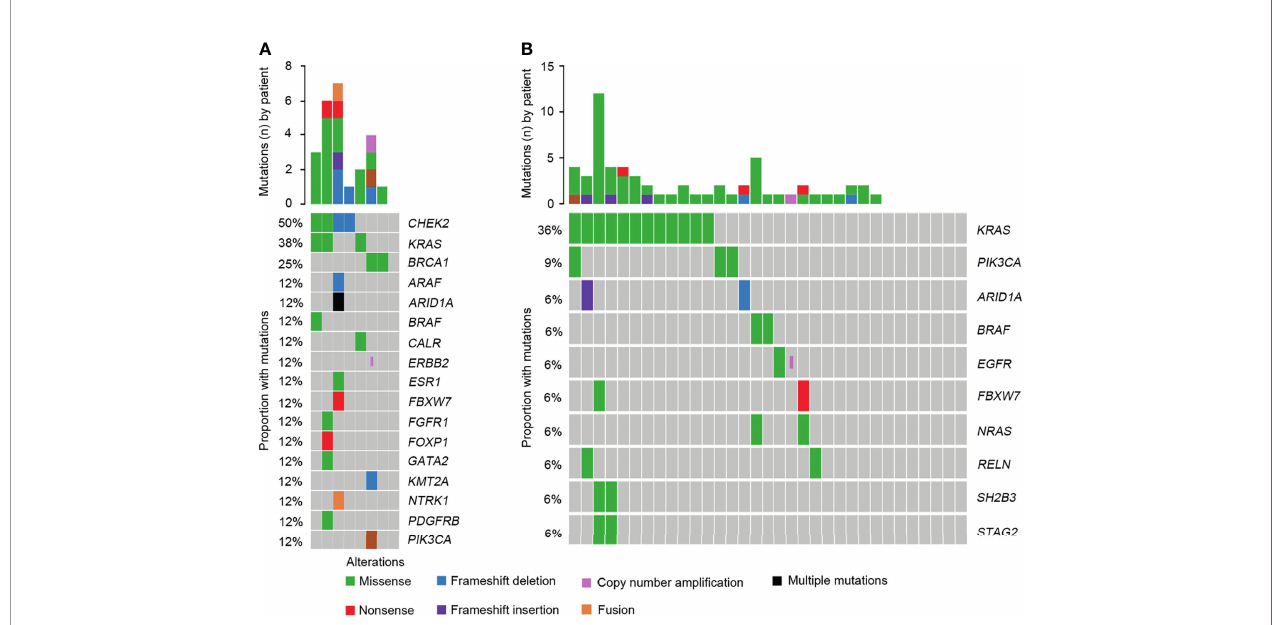
FIGURE 8 | Comparison of the targeted genomic pro fi les between CRC and NSCRC patients. (A) The targeted genomic pro fi le in the SCRC group. (B) The targeted genomic pro fi le in the NSCRC